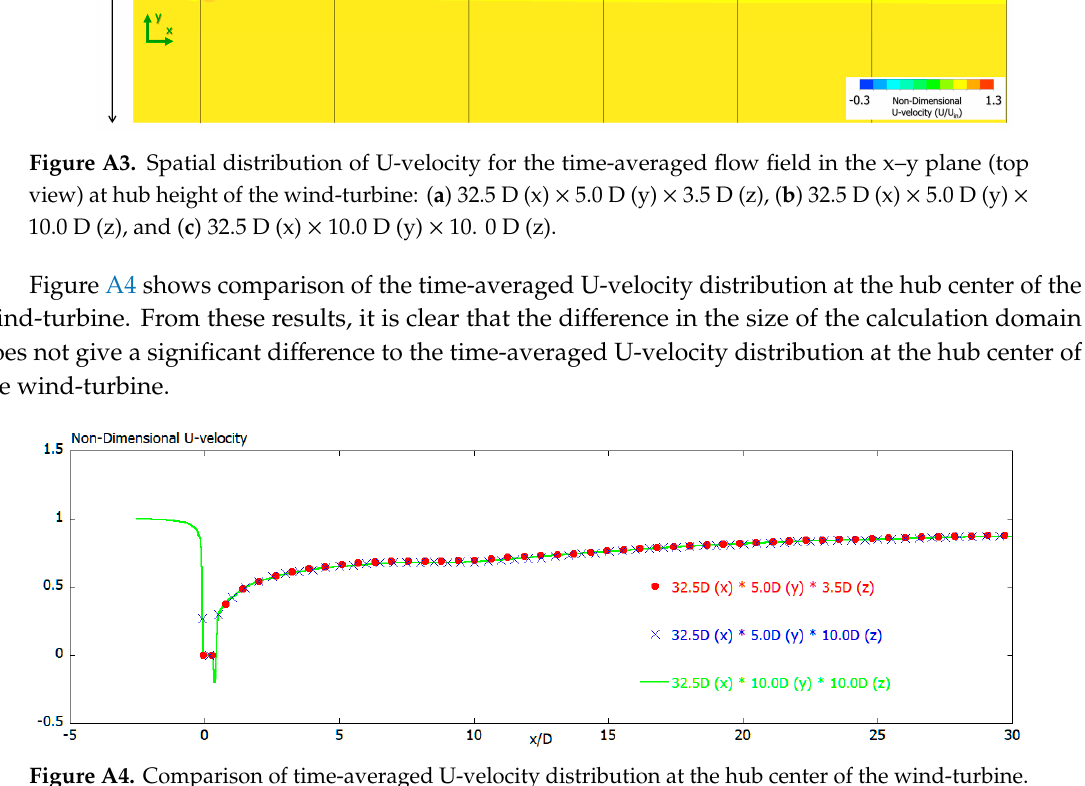
Figure A4. Comparison of time-averaged U-velocity distribution at the hub center of the wind-turbine.